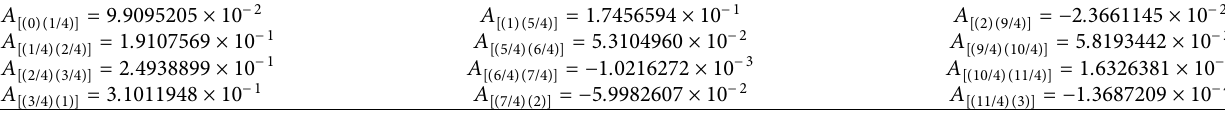
D � 4 and j � [ a,b ] for